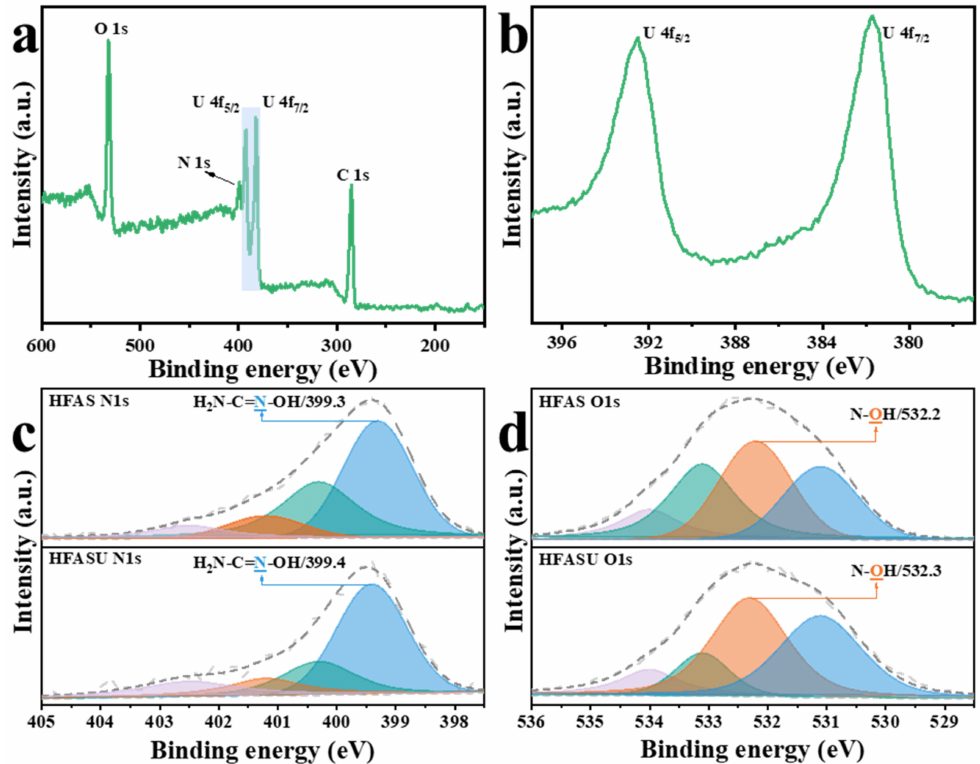
Figure 5. The XPS spectroscopy of HFASU ( a ), high-resolution spectra of U 4f ( b ), N 1s ( c ), and O 1s ( d ) of HFAS and